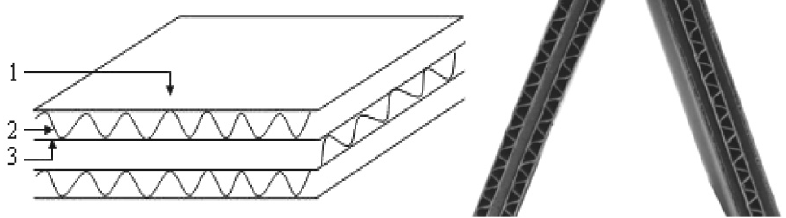
Fig. 1. Structure and photograph of the X-PLY corrugated paperboards. 1. Face sheet; 2. Corrugated core sandwich; 3. Inner